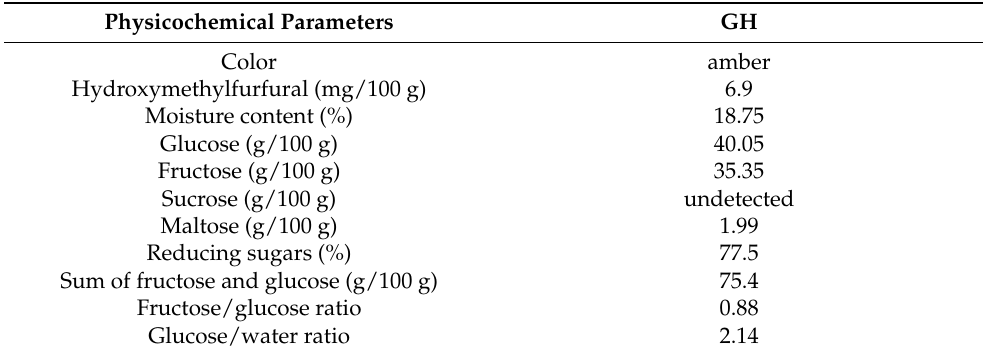
Table 7. Physicochemical characteristics of Malaysian Gelam honey (GH) for reference values. Physicochemical Parameters